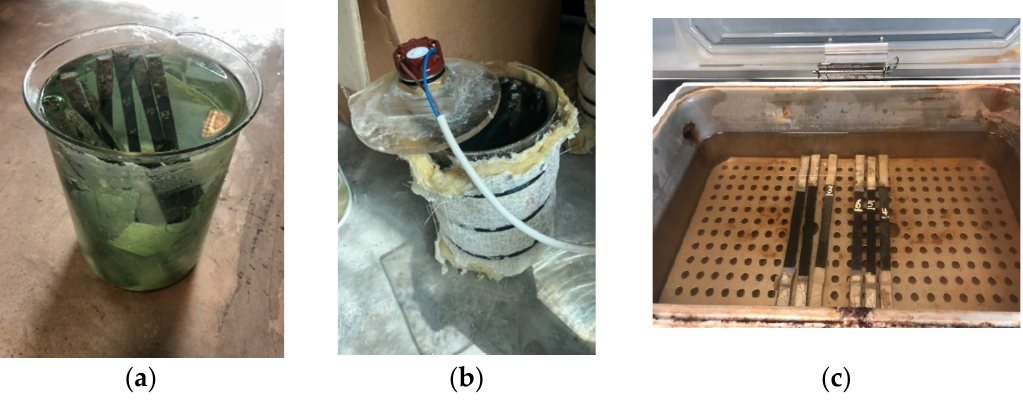
Figure 1. Conditioning of specimen at ( a ) 23 °C, ( b ) 65 °C and ( c ) 90 °C.